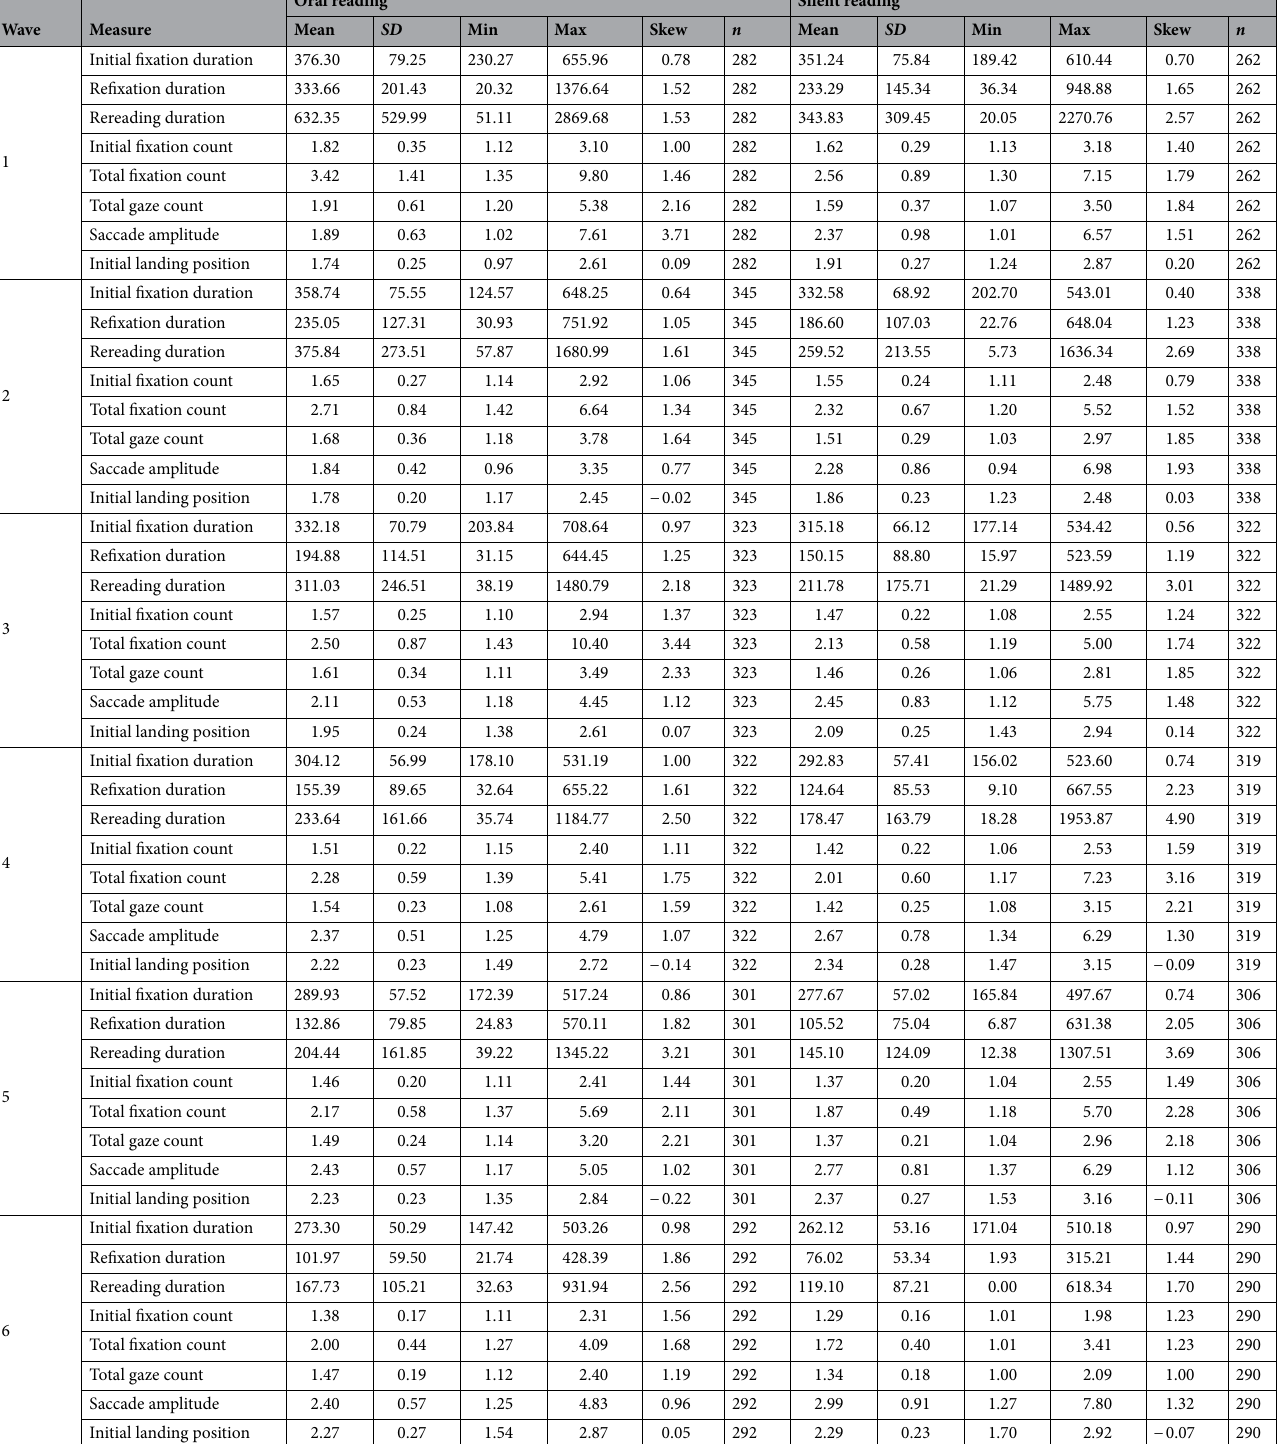
Table 1. Descriptive statistics among eye-tracking measures by wave and oral versus silent reading mode. Duration is in ms. Initial fixation duration = average of fixation duration, Refixation duration = average